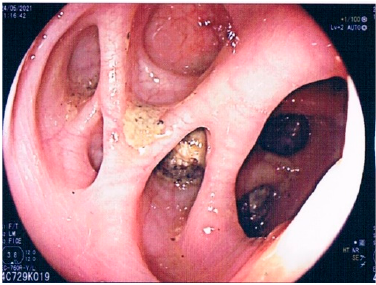
Figure 3. Massive diverticulosis with the stiffness of the lumen. Until the development of the DICA classification, the significance of these colonic characteristics was unknown. Now, this endoscopic picture can be scored as DICA 2 (left-sided diverticulosis: 2 points; >15 diverticula per district: 1 point; rigidity of the colonic wall: 4 points; total: 7 points), having an increased risk of developing complications related to the disease.